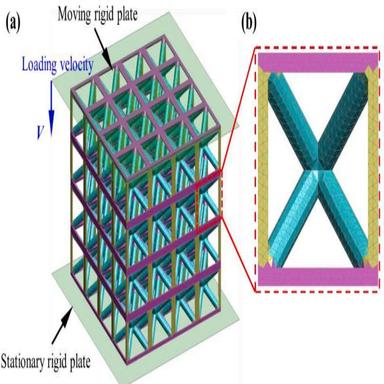
Numerical set-up of the SB lattice under compression along the printing vertical direction: (a) the established FE model and (b) mesh size.